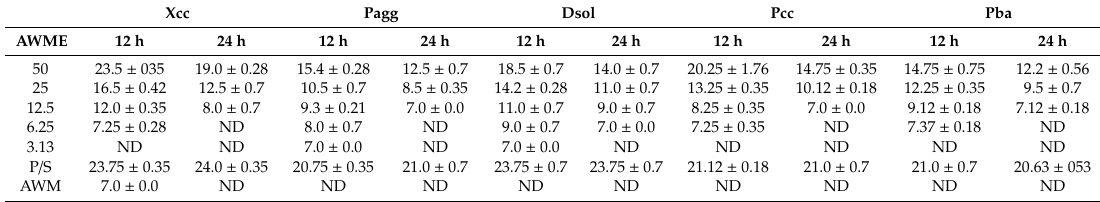
Table 2. Agar disk di ff usion assay. Antibacterial activity was measured using the agar disk di ff usion assay against Xanthomonas campestris pv. campestris (Xcc), Pantoea agglomerans (Pagg), Dickeya solani (Dsol), Pectobacterium carotovorum subsp. carotovorum (Pcc), and Pectobacterium atrosepticum (Pba) bacteria strains. The bacteria were exposed to 50, 25, 12.5, 6.25, and 3.13 mg / mL of extract from BSFL fat. The zone of bacterial growth inhibition was measured after 12 h and 24 h of incubation at 28 ± 0.5 ◦ C by the diameter of clear zone surrounding of the discs (in mm). Penicillin-streptomycin (p / s) was used as an antibacterial positive control. The AWME solution was used as negative control. The results presented as means of inhibitory zone ± standard deviation of three independent experiments in duplicates. ND, not detectable; AWME, extract from BSFL fat; AWM extraction solution: